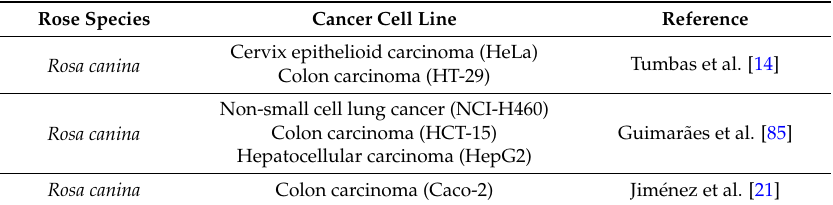
Table 1. Anticancer activity of some Rosa species related to their antioxidant